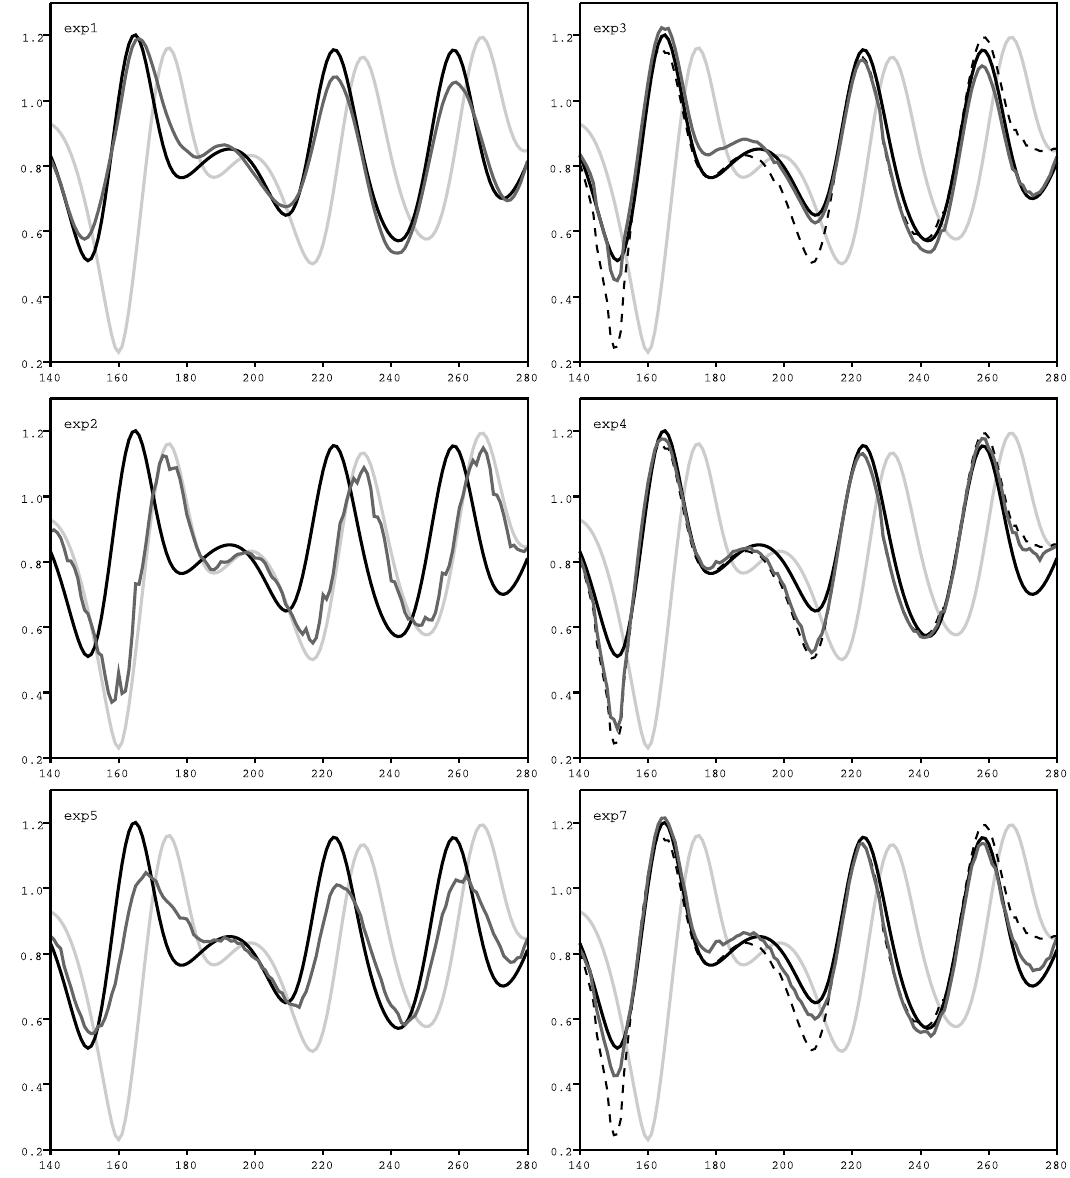
Fig. 4. Examples of assimilation for six relevant experiments described in Table 1. The only difference between the panels on the same line is that translation is (resp. not) applied on the right (resp. left). The nature state (solid black curve) and the background (solid light grey curve) are the same in each panel. The translated background is the dashed curve when relevant (right panels). The results of assimilation are plotted in solid dark grey.